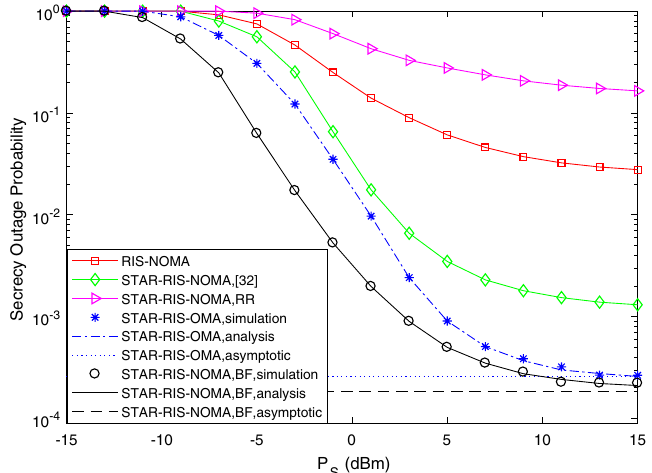
Fig. 3 The theoretical results and simulation results of SOP versus transmit power. the SOP of four schemes for NOMA versus